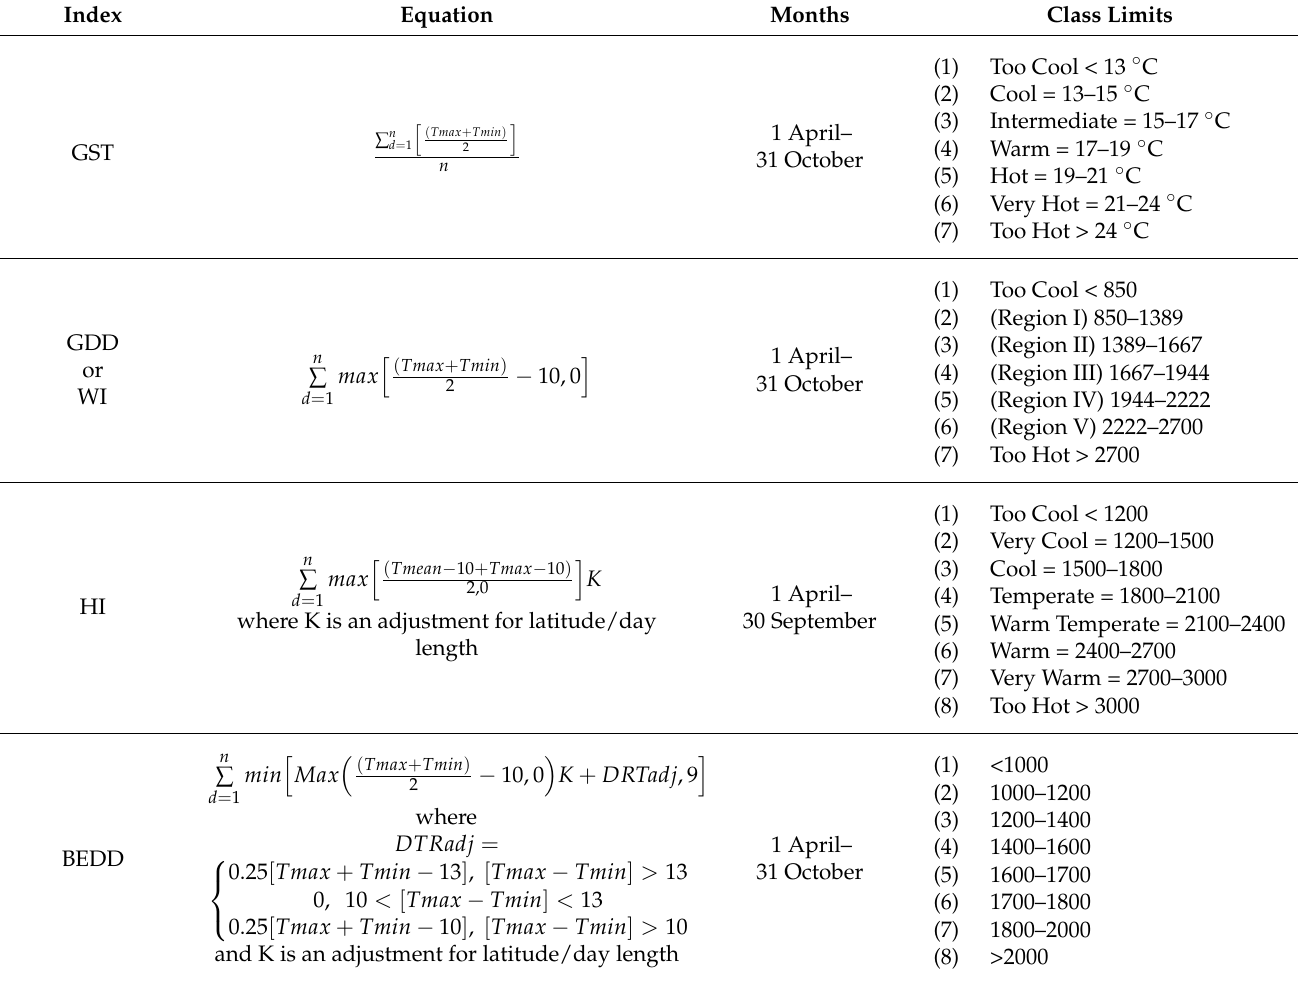
Table 2. Temperature-derived indices used in the